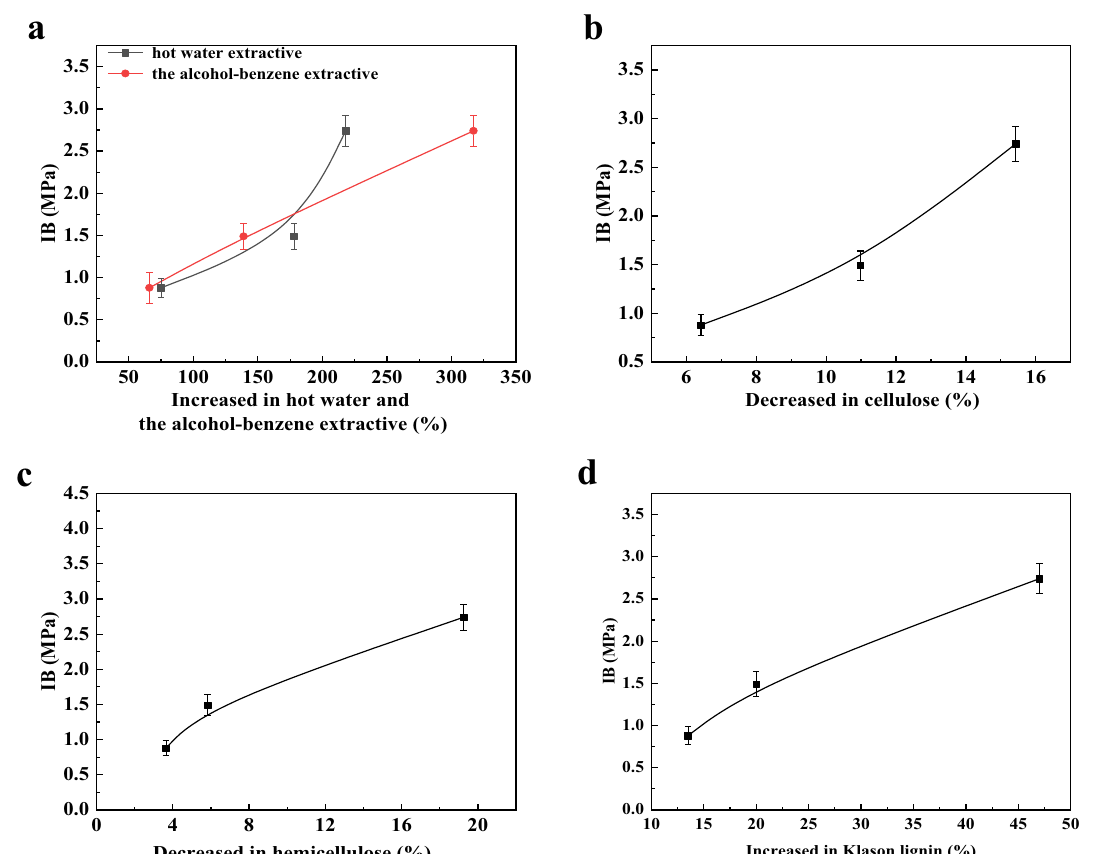
Fig. 7 Correlation between the change in chemical composition and IB strength of binderless board. a Effect of an increase in extractives on IB strength of binderless board. b Effect of a decrease in cellulose on IB strength of binderless board. c Effect of a decrease in hemicellulose on IB strength of binderless board. d Effect of an increase in Klason lignin on IB strength of binderless board. Error bars indicate standard